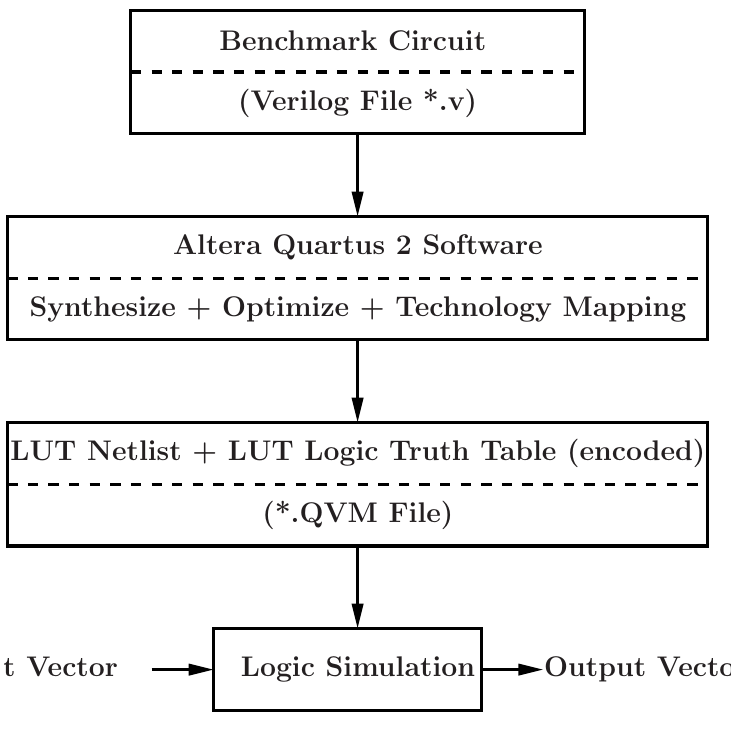
Figure 10. CAD flow of our circuit design experiments.